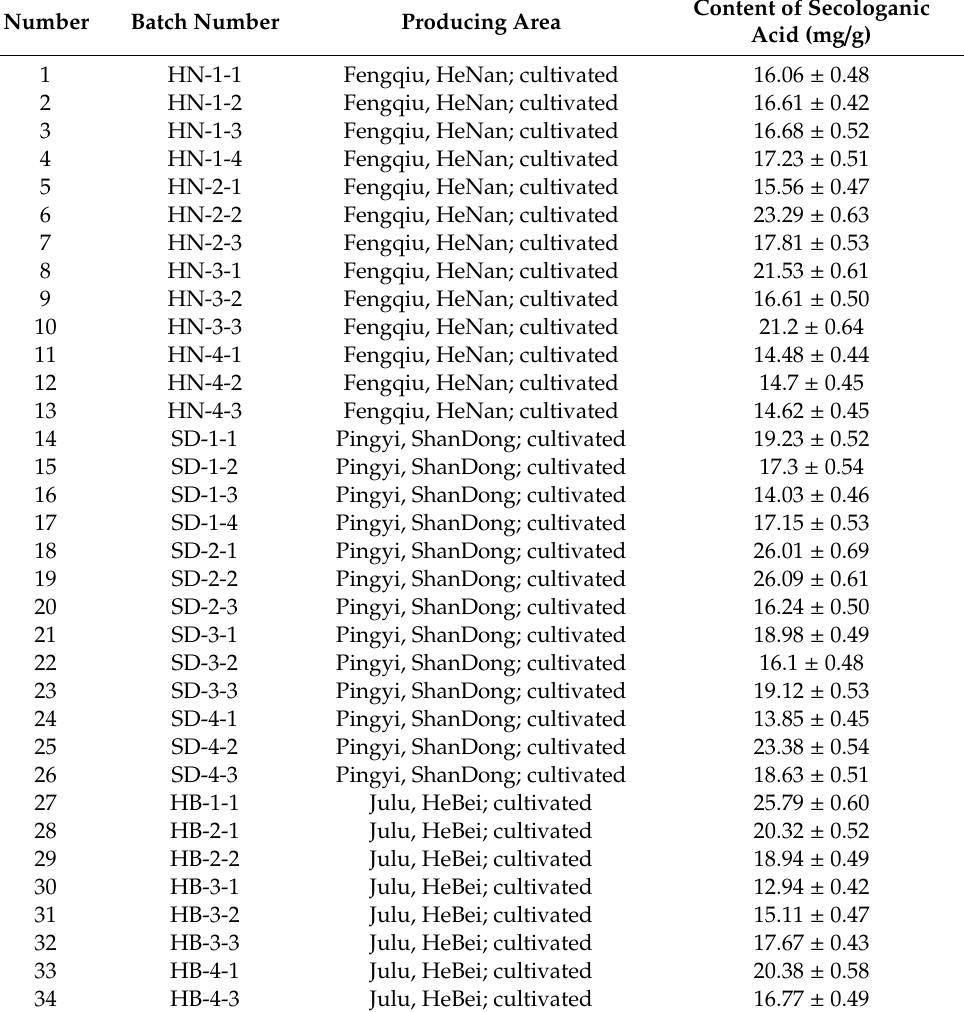
Table 1. Contents of secologanic acid in samples of LJF ( n = 3, x ±